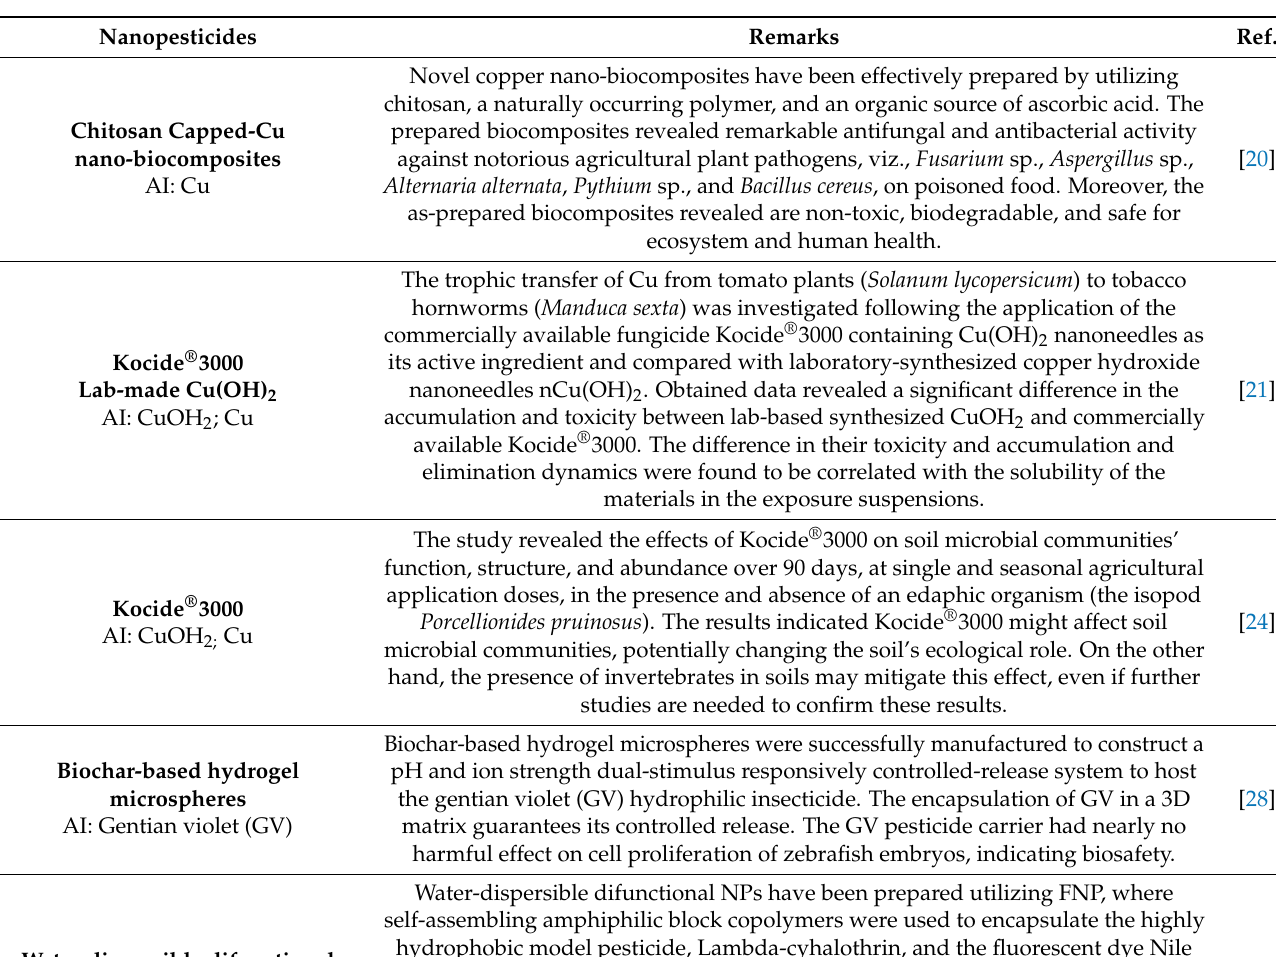
Table 1. Recent innovations on slow-release